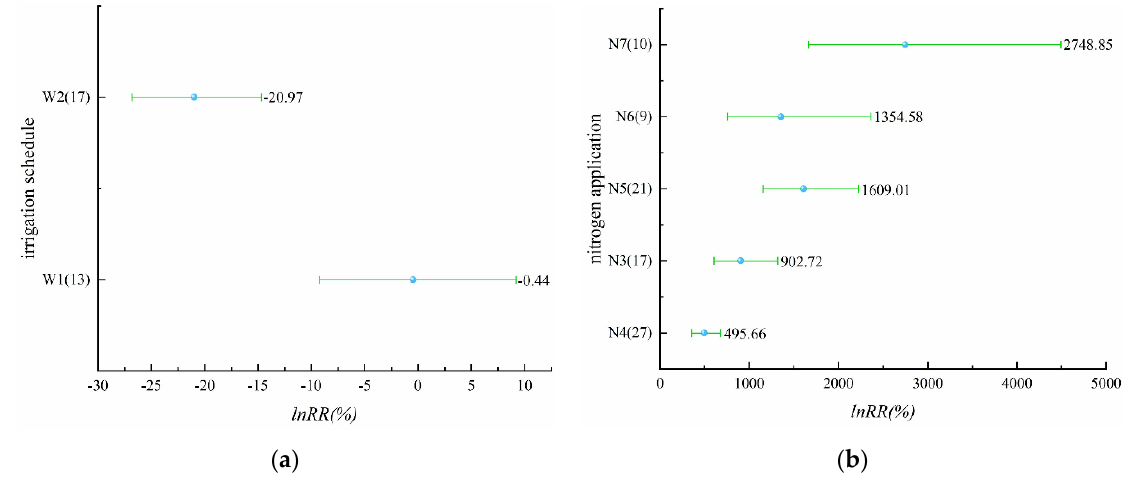
Figure 9. ( a ) Effect of different irrigation schedules on ammonia volatilization ( p = 0.02987); ( b ) effect of different nitrogen application levels on ammonia volatilization ( p = 0.00000).